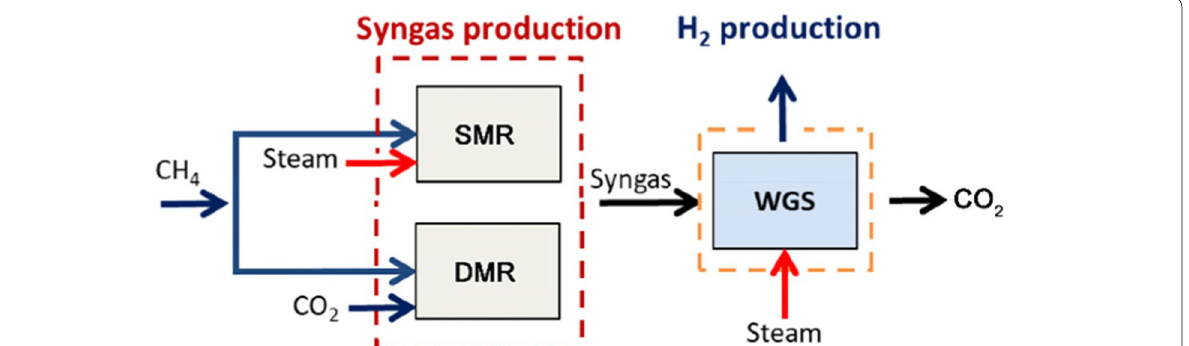
Fig. 7 Pathways for H 2 -riched fuel gas conversion: WGS – water gas shift; SMR –steam methane reforming; DMR –dry methane